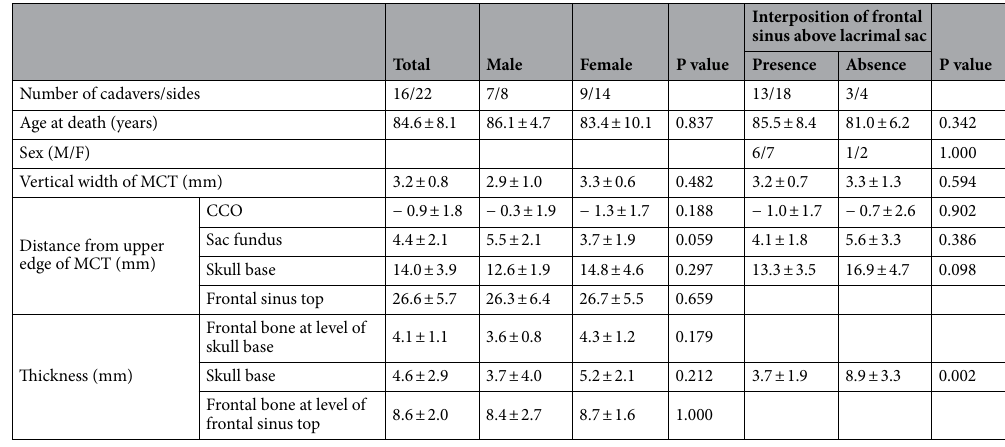
Table 1. Demographic data on cadavers, measurement results, and statistical comparison in the experimental study. M, male; F, female; MCT, medial canthal tendon; CCO, common canalicular